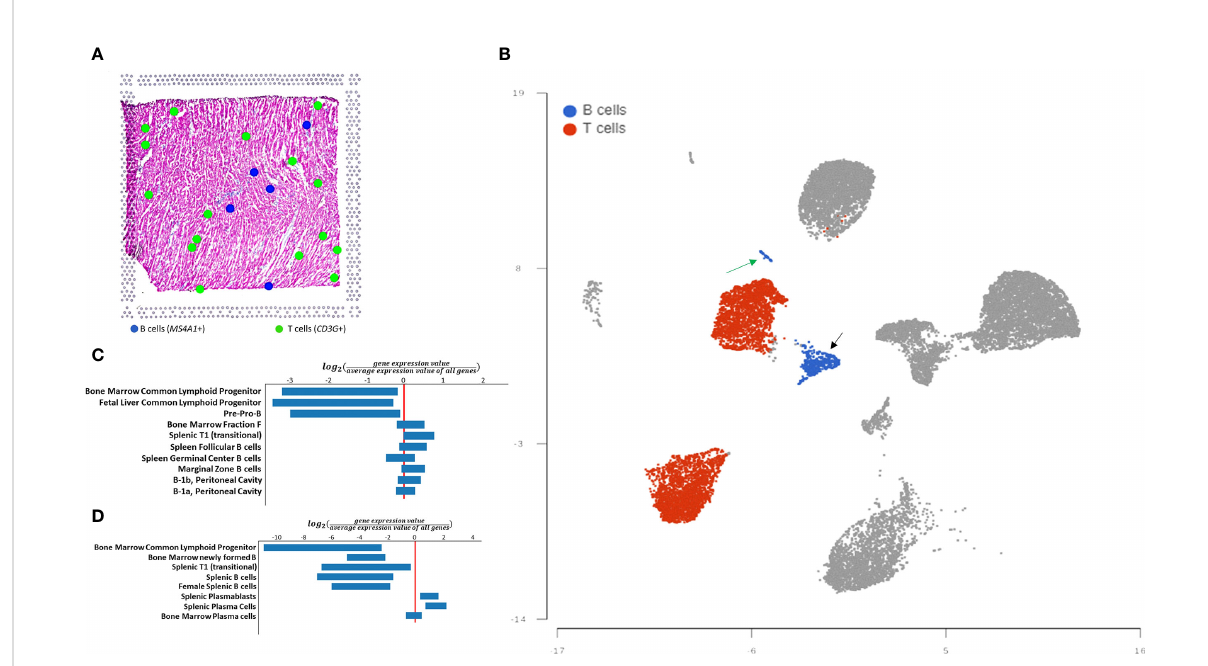
FIGURE 2 Spatial transcriptomics and single cell-based analysis of human myocardial B-cells. (A) Distribution of B-cells, and T-cells in myocardial tissue analyzed with 10X Visium spatial transcriptomics technology. Blue dots represent tissue regions where expression of the B-cell marker MS4A1 is identi fi ed. Green dots represent tissue regions where expression of T-cell gene expression marker CD3G is identi fi ed. (B) UMAP plot of single- cell gene expression analysis of myocardial immune cells from the human Heart CEll Atlas. B-cells are highlighted in blue and T-cells are highlighted in red. B-cells represent 3% of all immune cells (1,196 of 40,868) while T-cells represent 24% of the same population (10,297 of 40,868). (C) ImmGen MyGeneSet analysis of the genes with the highest differential expression between the larger B-cell cluster and the rest of the immune cells analyzed. The analysis suggests that this B-cell population is most similar to T1 (transitional) B-cells. (D) ImmGen MyGeneSet analysis of the genes with the highest differential expression between the smaller B-cell cluster and the rest of the immune cells analyzed. The analysis suggests that this B-cell population is most similar to plasma